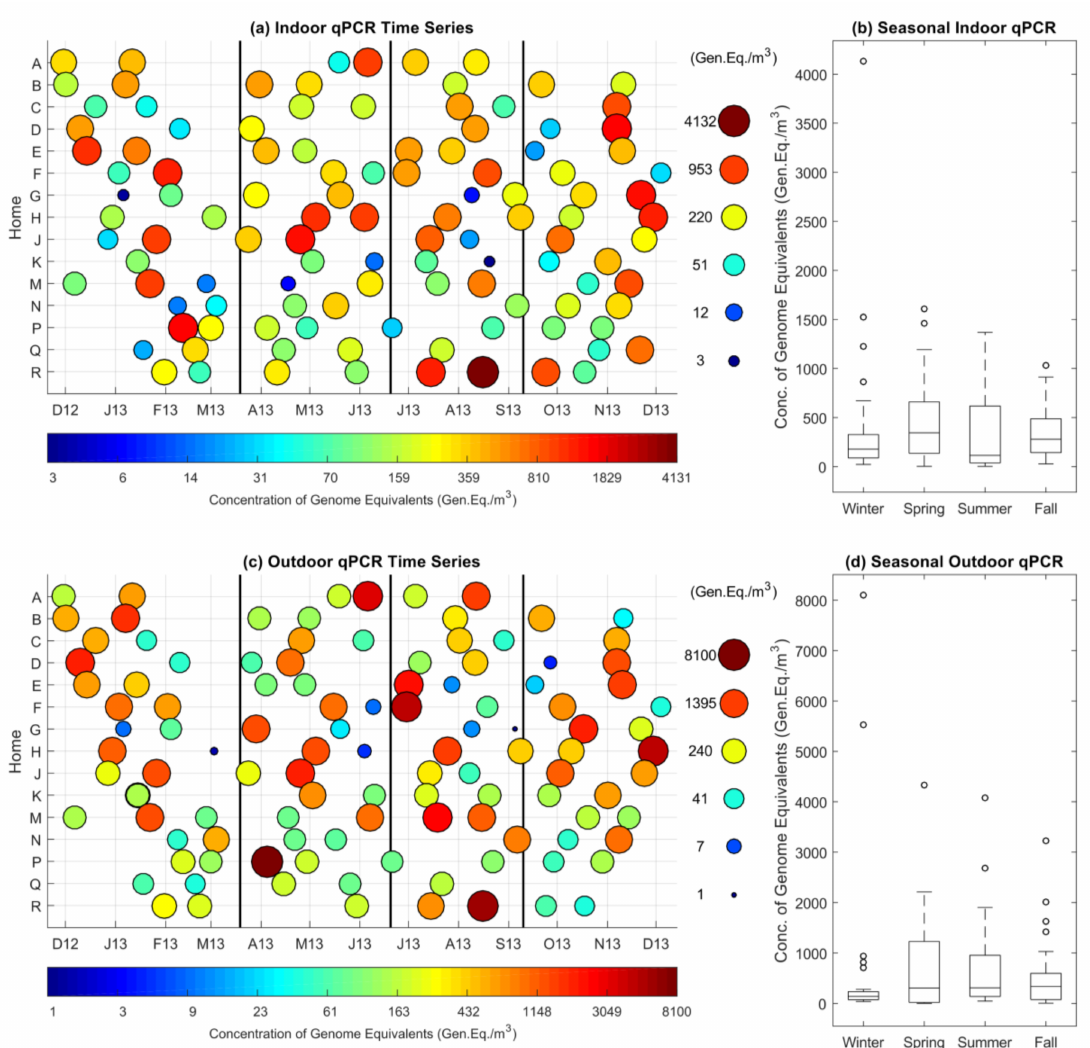
Figure 5. ( a ) Indoor qPCR concentrations; ( b ) seasonal box plots of indoor qPCR concentrations; ( c ) outdoor qPCR concentrations; and ( d ) seasonal box plots of outdoor qPCR concentrations (color and marker size are on a logarithmic scale and indicate qPCR concentrations; vertical bars separate